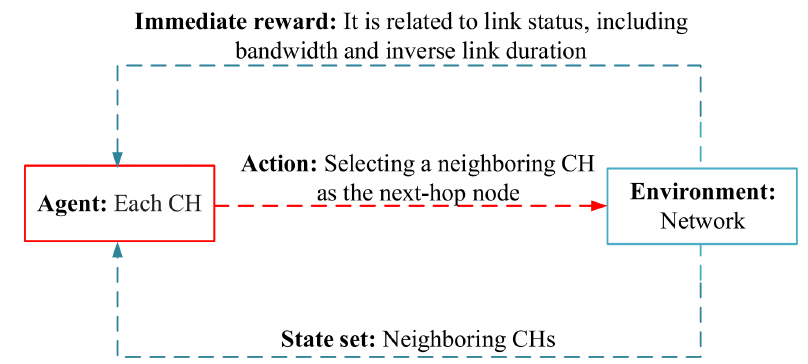
Figure 18. Learning structure in